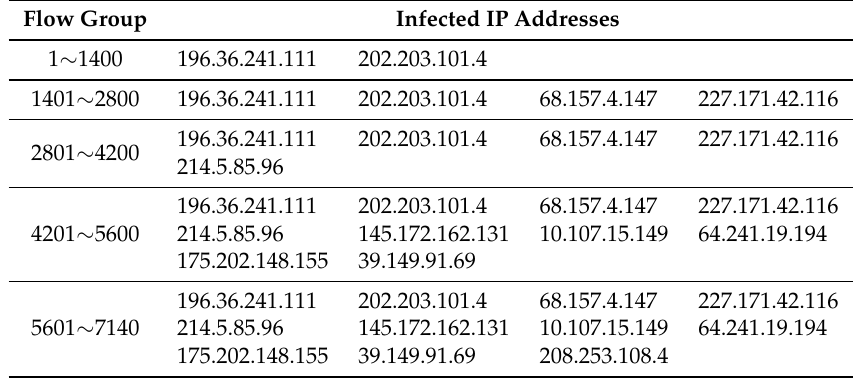
Infected IP addresses in the dataset for each flow group under the UDP worm simulation experiment.